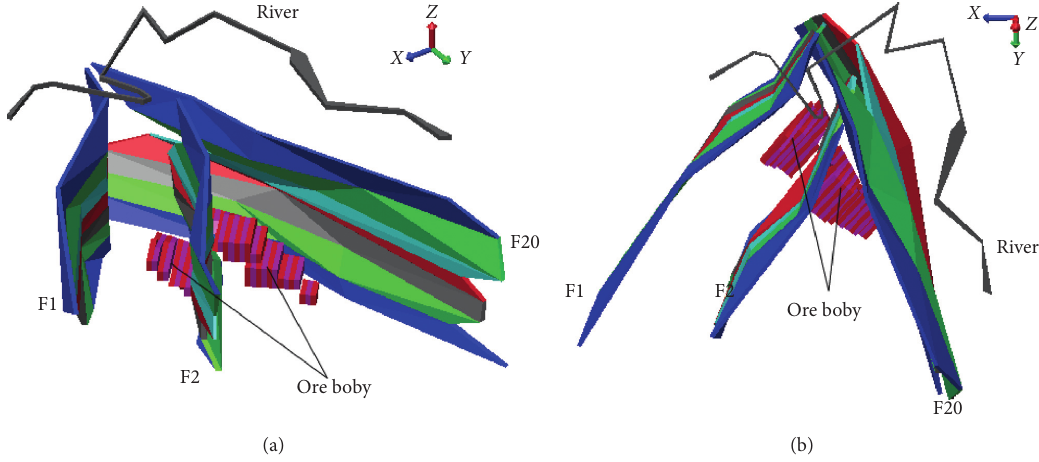
Figure 4: Spatial relation map of rivers, faults, and ore bodies. (a) Perspective one. (b) Perspective two.